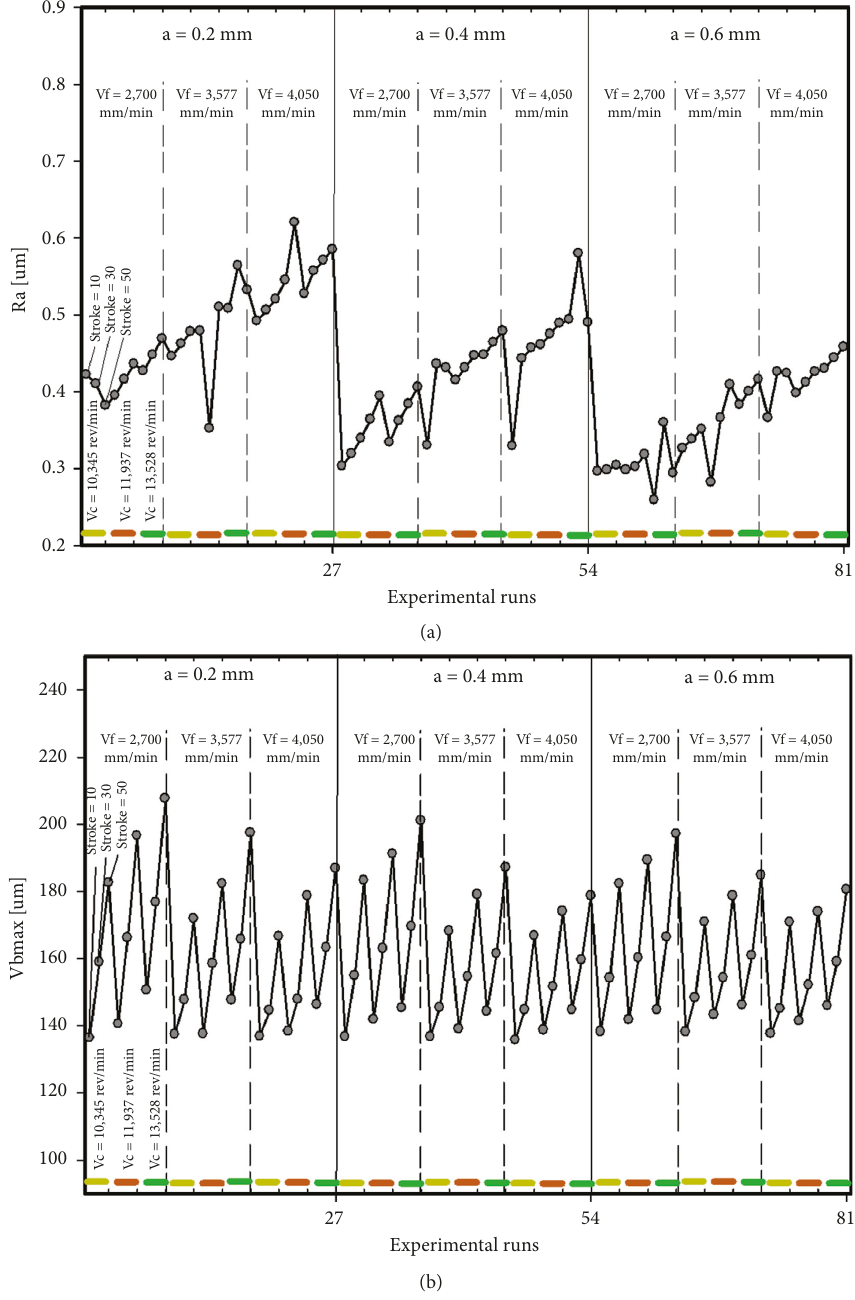
Figure 7: The effect of cutting parameters on the (a) surface roughness and (b) tool